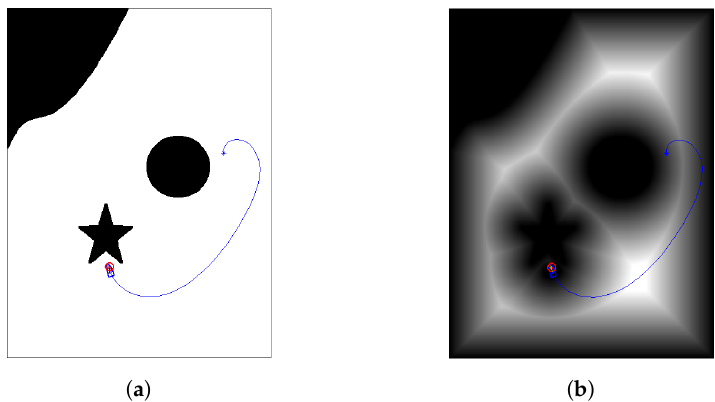
Figure 17. The simulation final result in a static simulation environment. ( a ) The binary map; ( b ) The potential